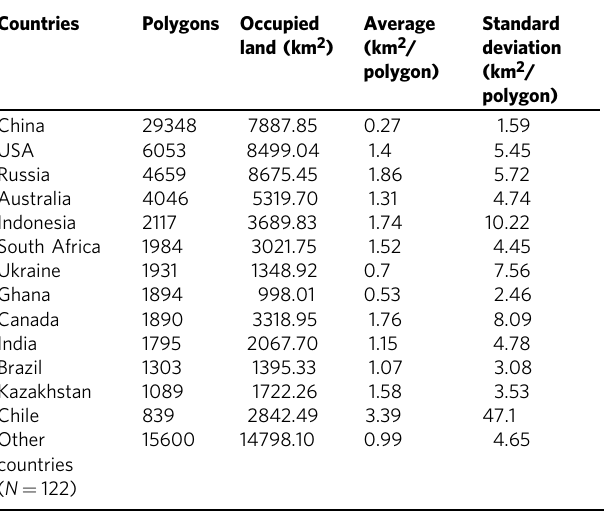
Table 1 Summary of per-country mine areas mapped in this